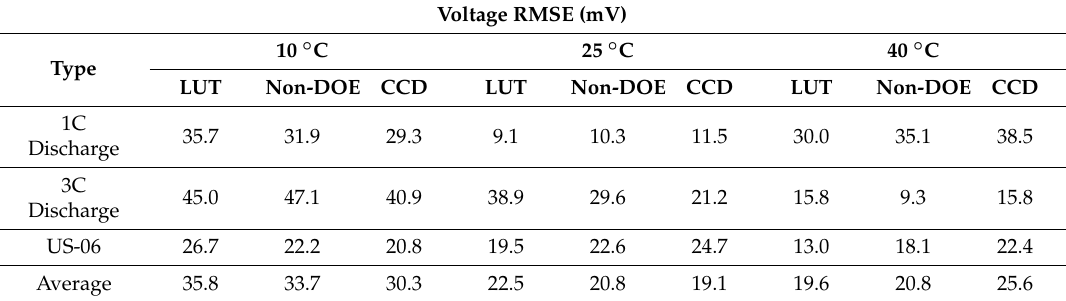
Table 7. Root mean squared error for the temperature response for LUT and Non-DOE techniques in comparison to the face-center CCD